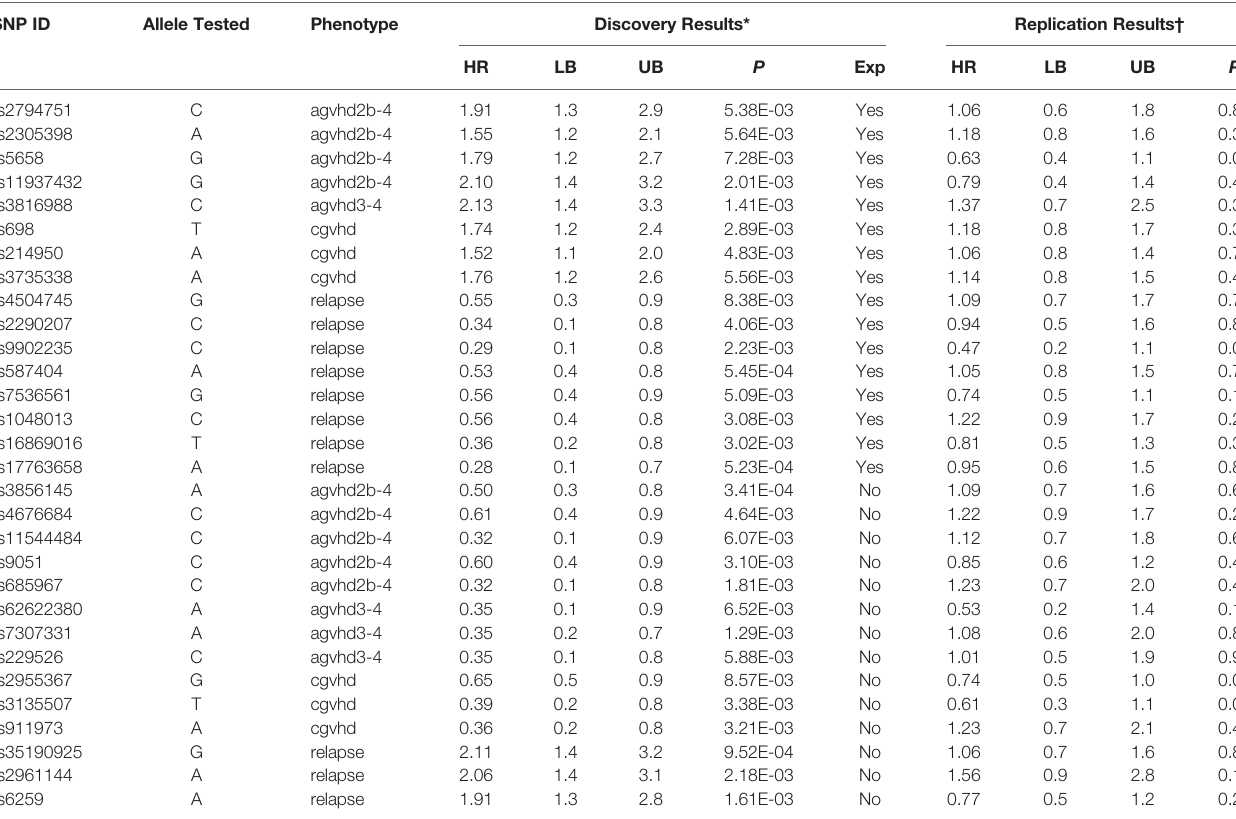
TABLE 2 | HLA-A*02:01-restricted discoveries prespeci fi ed for replication testing. SNP ID Allele Tested Phenotype Discovery Results* Replication Results †